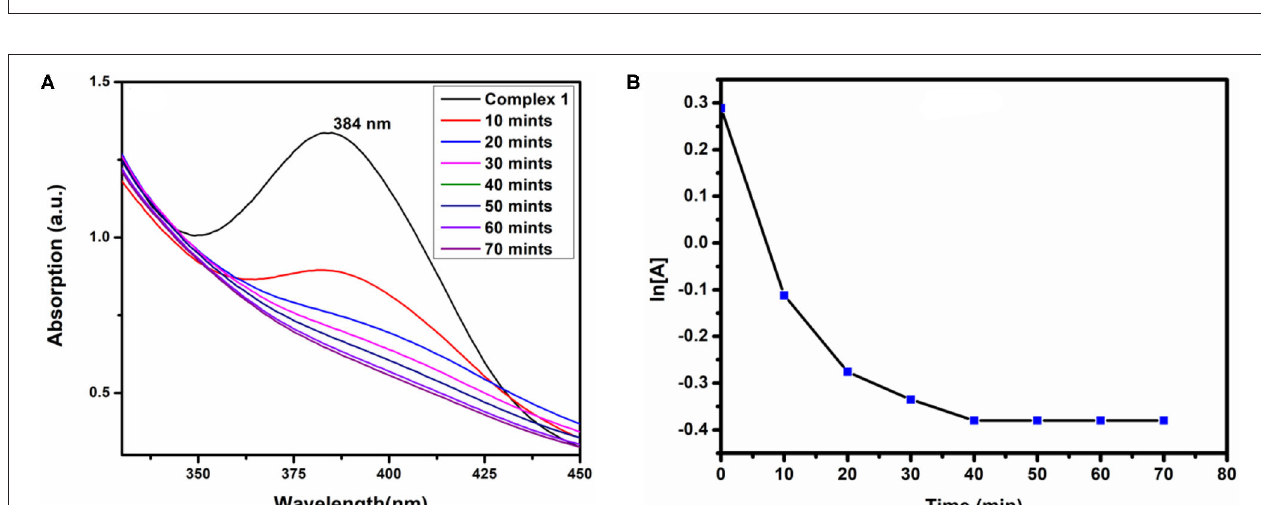
FIGURE 10 | H 2 O 2 sensing (A) and first order of reaction (B) of complex